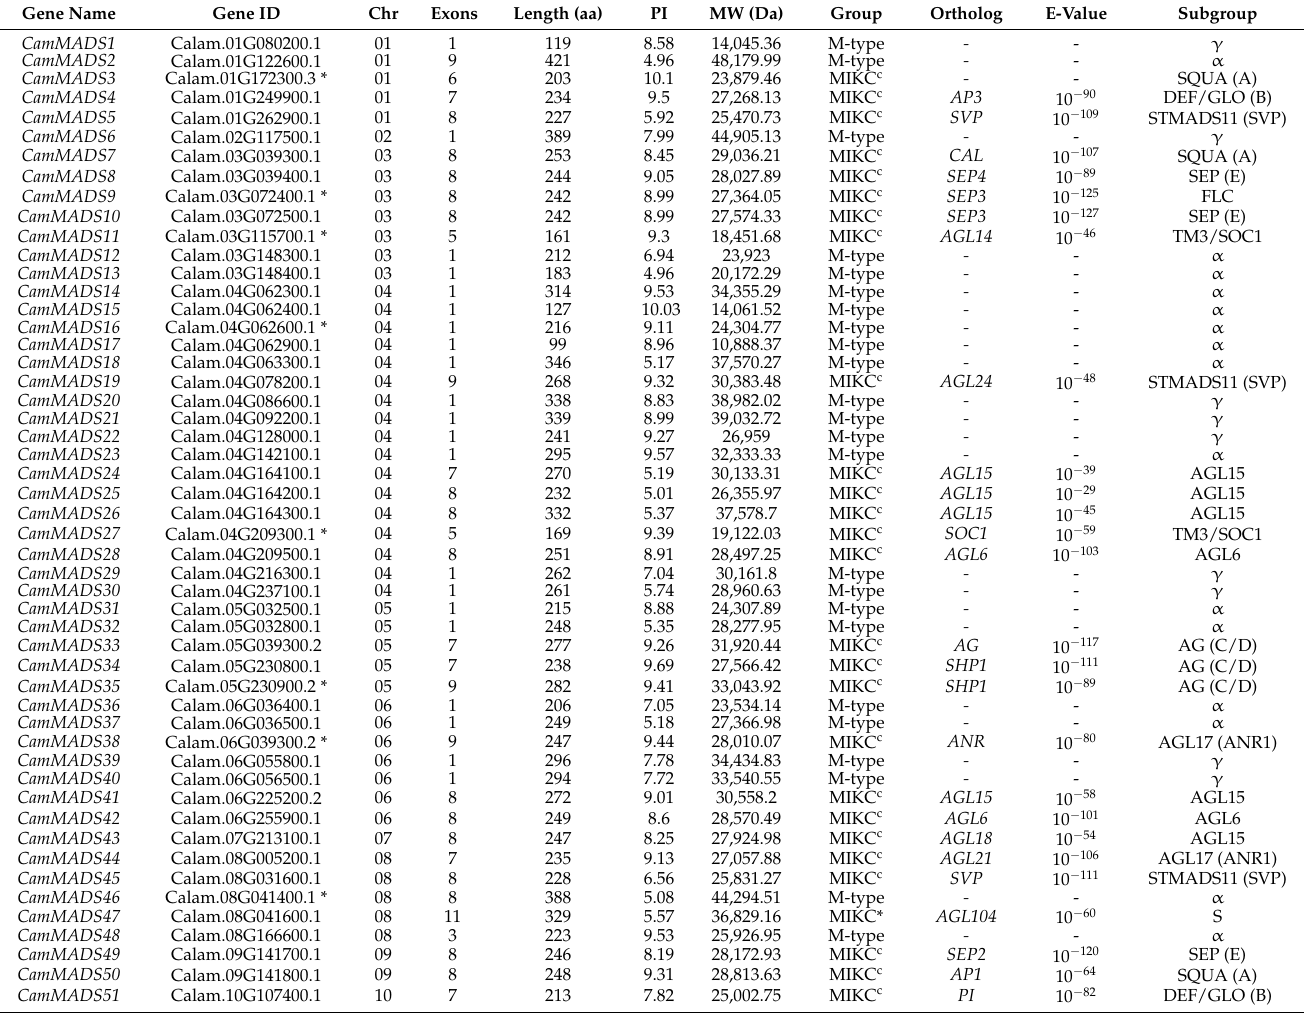
Table 1. Detailed information for the MADS-box gene family in C. americana